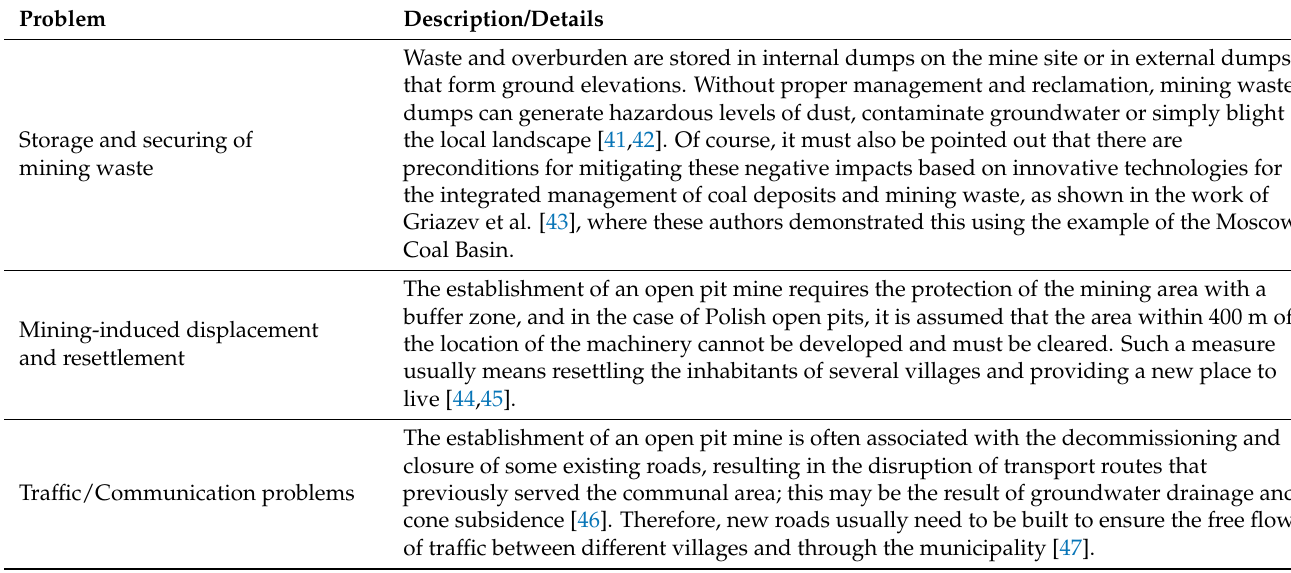
Table 4. Negative impacts in lignite life